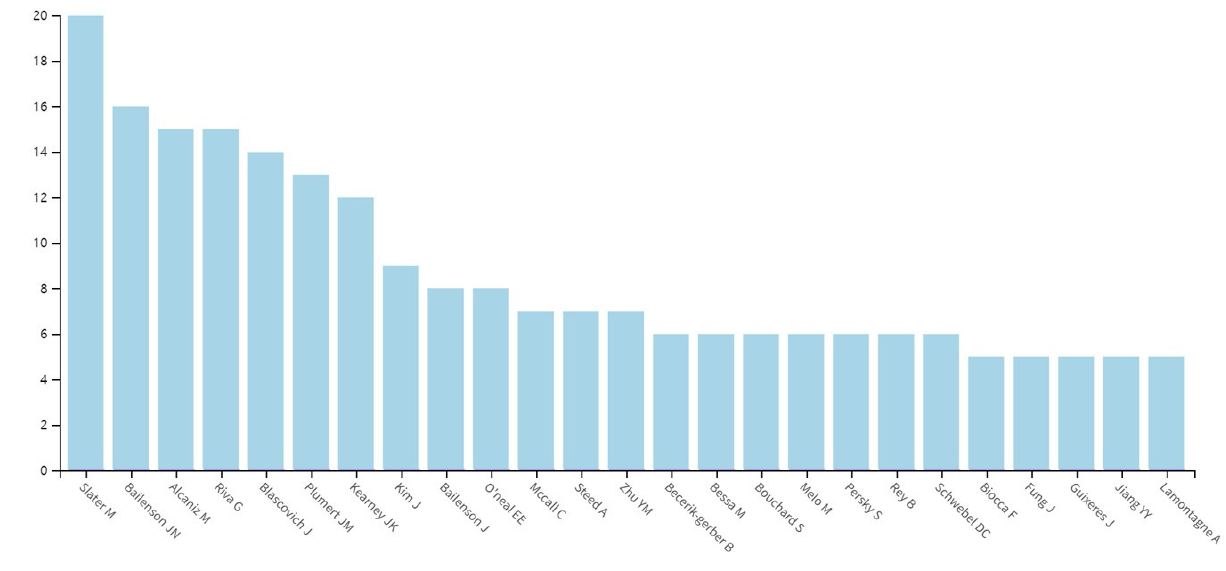
Figure 4. Most prolific authors. Table 5. The top 10 most prolific authors.